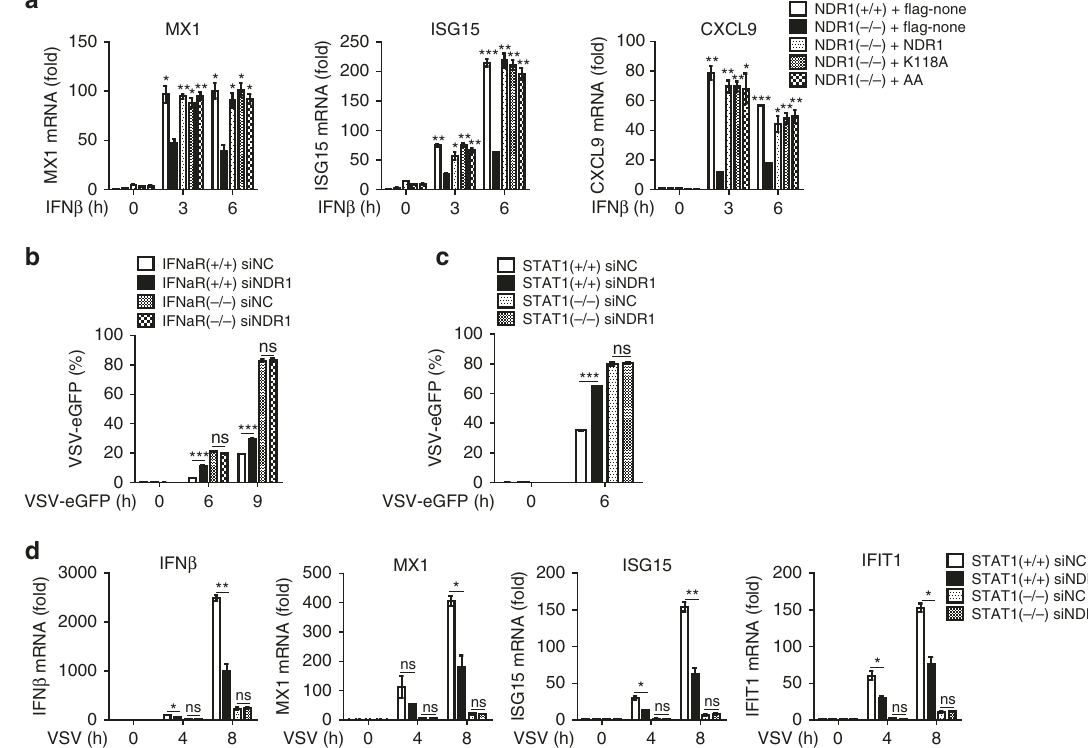
Fig. 5 NDR1 positively regulates antiviral immune response via promoting STAT1 expression. a Real-time PCR analysis of ISGs mRNA in WT or NDR1 − / − PMs transfected with vectors expressing NDR1 or its kinase-inactive mutants, followed by stimulation with IFN β (100 IU ml − 1 ). b , c FACS analysis of immortalized BMDMs obtained from WT and IFN α receptor-de fi cient mice ( b ) or from WT and STAT1 − / − mice ( c ), treated with NDR1-speci fi c or scrambled siRNA for 48 h, followed by VSV-eGFP infection. d Real-time PCR analysis of IFN β and ISGs mRNA in BMDMs as in c . Data are mean ± SD and are representative of three independent experiments. Student ’ s t test was used for statistical calculation. * p < 0.05, ** p < 0.01, *** p < 0.001. See